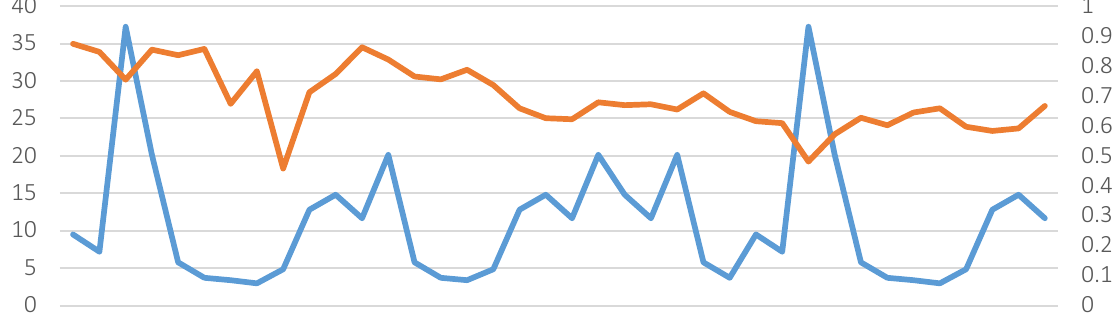
Figure 1. Carbon emissions and non-performing